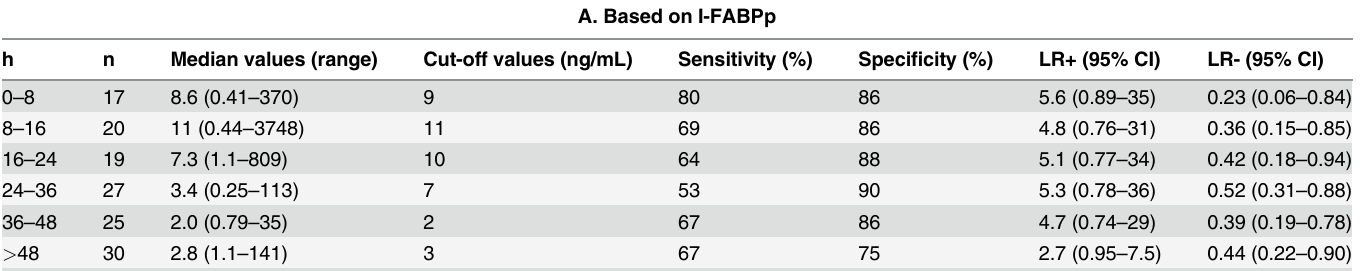
Table 2. Cut-off Values, likelihood ratios, and other test characteristics of I-FABPp (A) and I-FABPu (B) as a predictive test for the presence of NEC from 0 – 48 h after onset of symptoms (n =